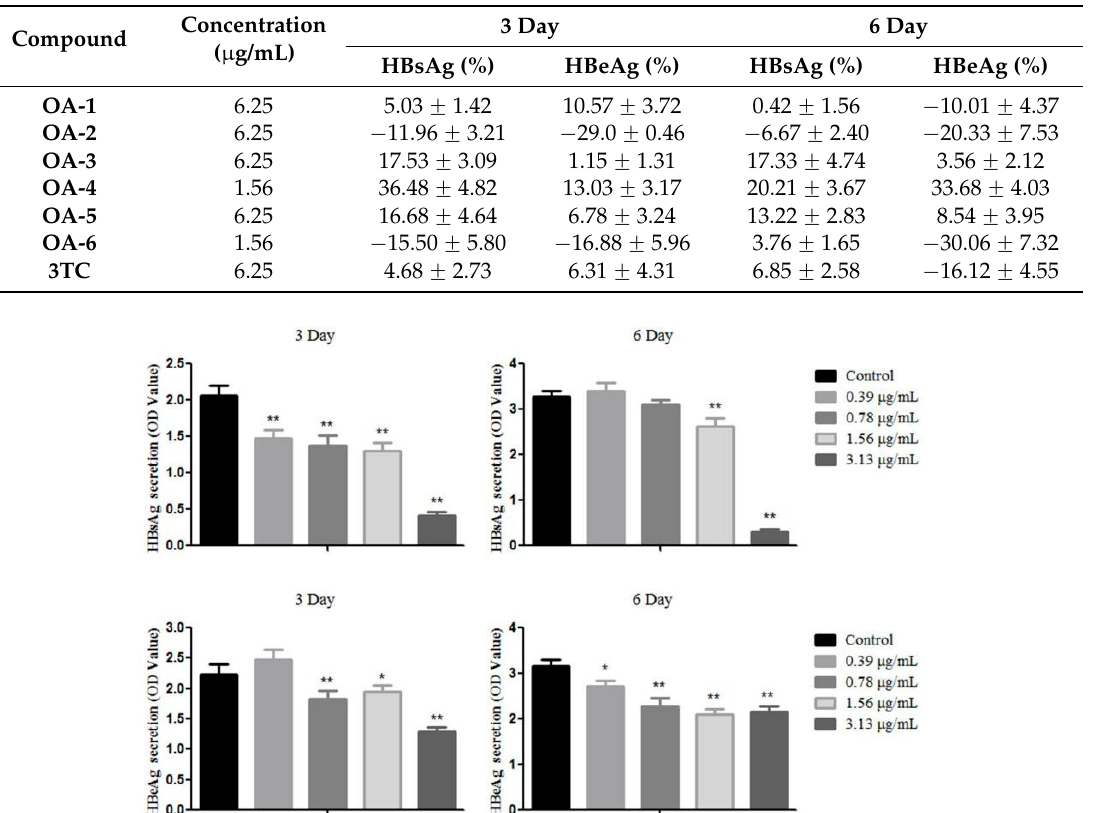
Figure 4. The activity against HBV antigen secretion of OA-4 in HepG2.2.15 cells. Data are expressed as OD value ± SD based on three independent experiments. ** p < 0.01, * p < 0.05 compared with the control group.